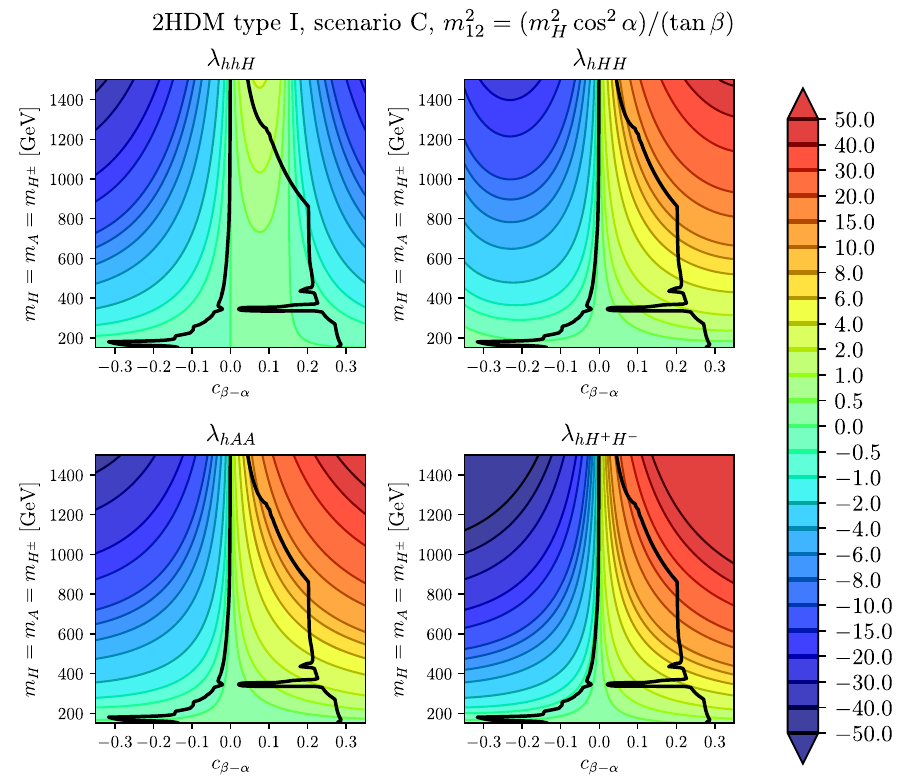
Fig. 13 Contour lines for triple Higgs couplings in the 2HDM type I, scenario C, in the ( c β − α , m ) plane for m = m H = m A = m H ± , = ( m 2 m 2 cos 2 α)/( tan β) and tan β = 10. Upper left: λ hhH , upper right: λ hHH , lower left: λ hAA , lower right: λ hH + H − . The thick solid contour H 12 is as in Fig.